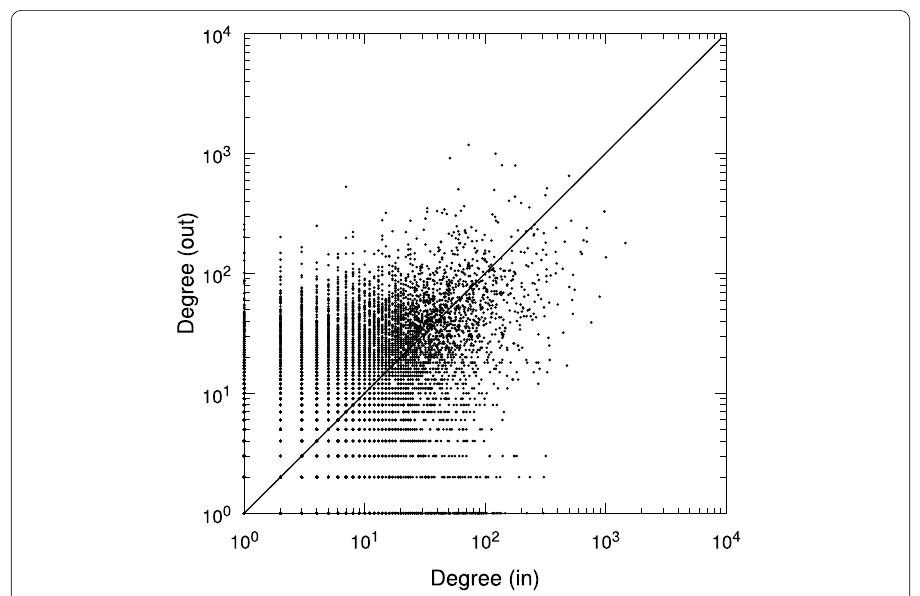
Figure 3 Scatter plot for in-degree and out-degree of each account. Each account as a node, represented as a point, has incoming links and outgoing links, the numbers of which are represented by the horizontal and vertical axes, respectively. The diagonal line represents the locations where the in-degree and out-degree are equal